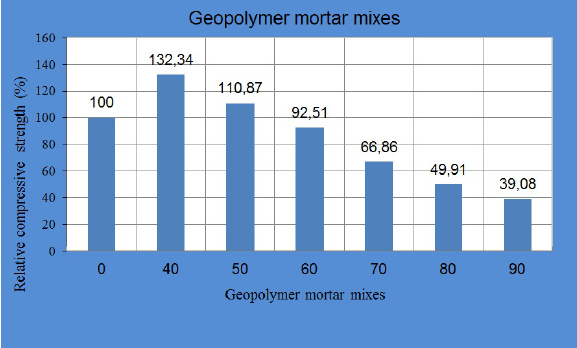
Figure 1: Relative compressive strength for geopolymer mortar mixes Table 13: Compressive strength for geopolymer mortat reinforced